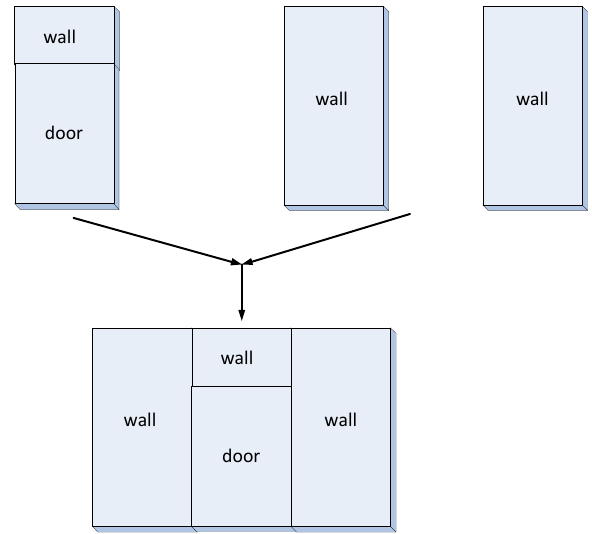
Figure 6: The construction of a door with its adjacent wall